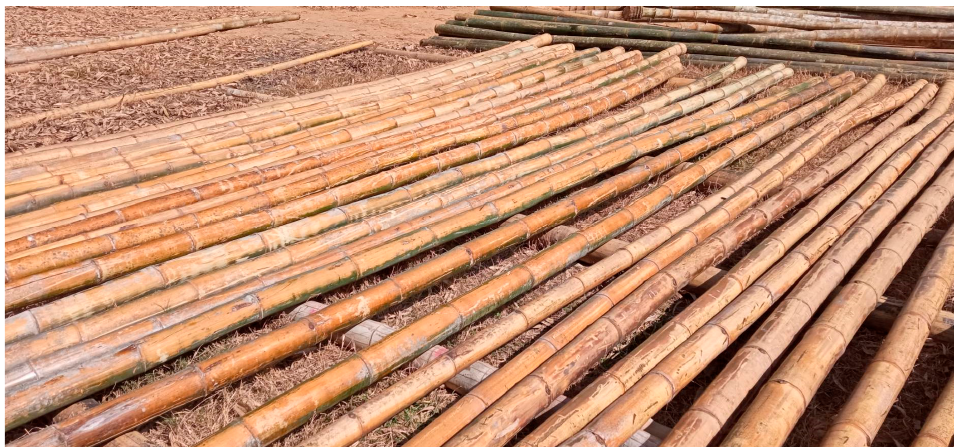
Figure 2. Bamboo turns from green to yellow.